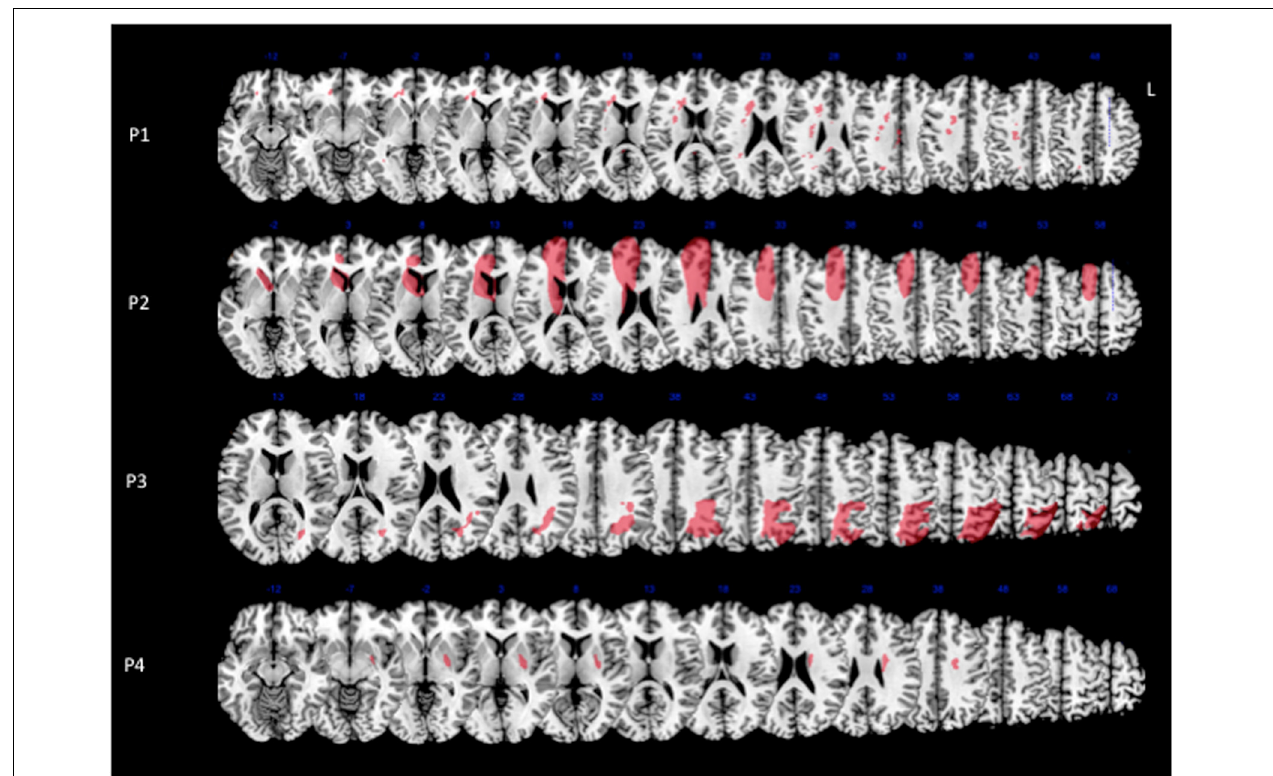
FIGURE 1 | Lesion reconstructions for each MN patient on the axial sections of the Montreal Neurological Institute (MNI) standard brain in radiological convention (L,